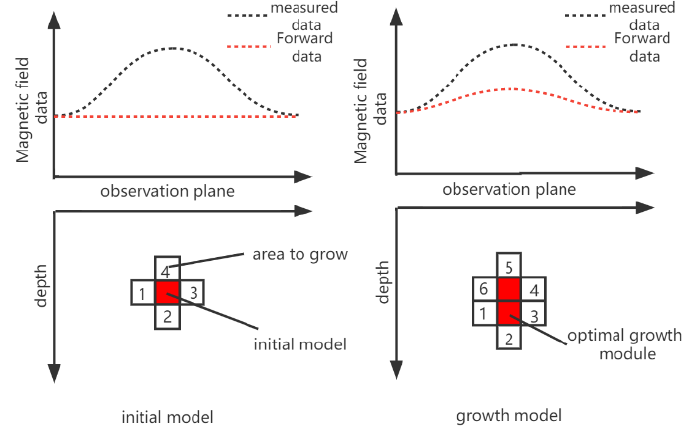
Figure 2. Module growth process.